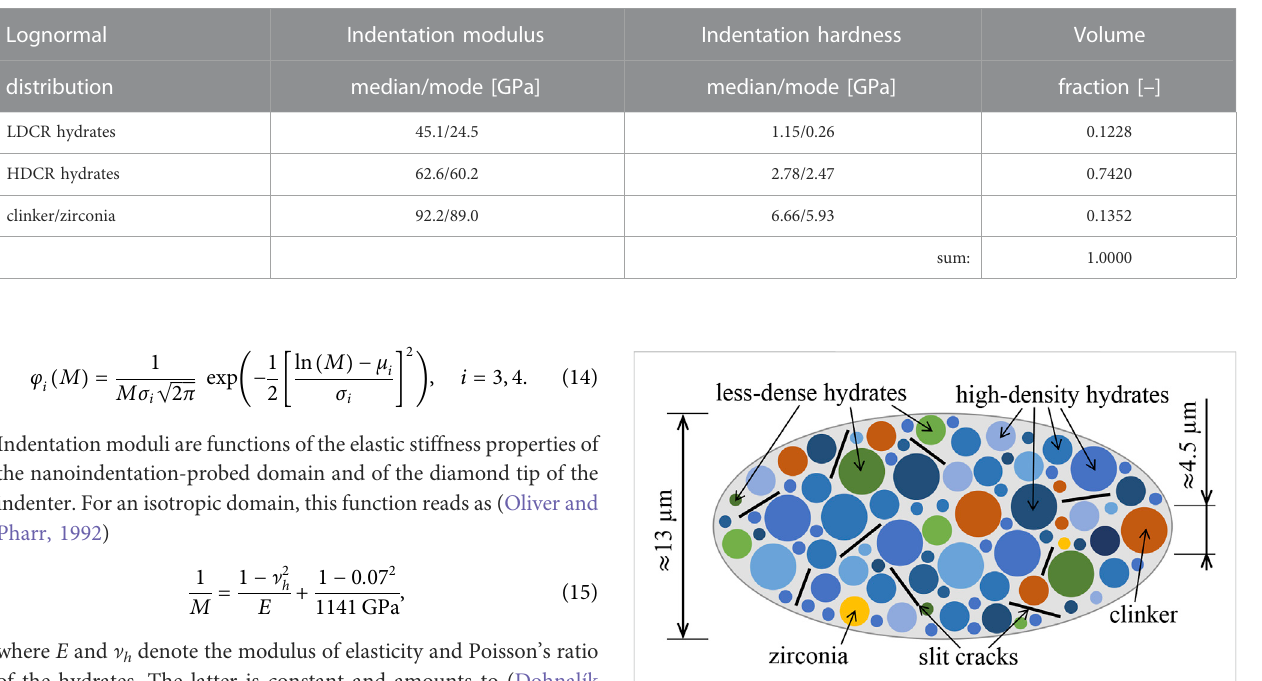
FIGURE 10 Continuum micromechanics representation of Biodentine after Dohnalík etal. (2022):spherical solidphases andisotropically oriented circular slit cracks in direct mechanical interaction.